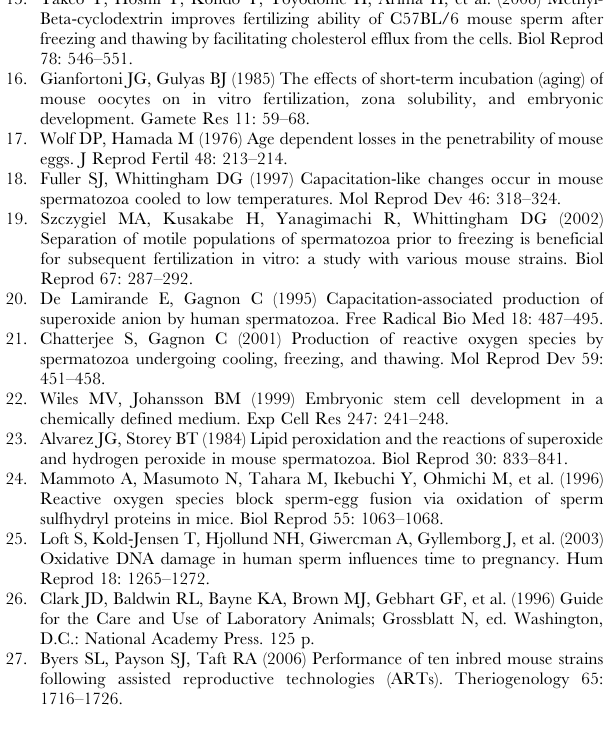
Figure S2 Efficiency of genetically modified (GM) line recovery.